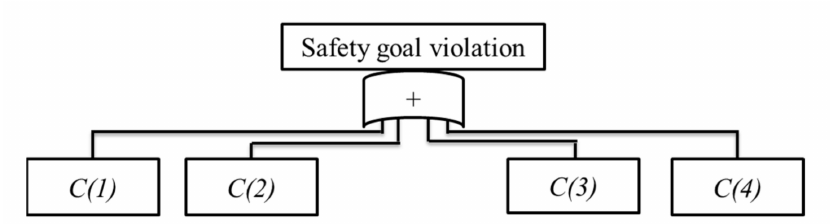
Figure 4. Constructed fault tree for the simple system.